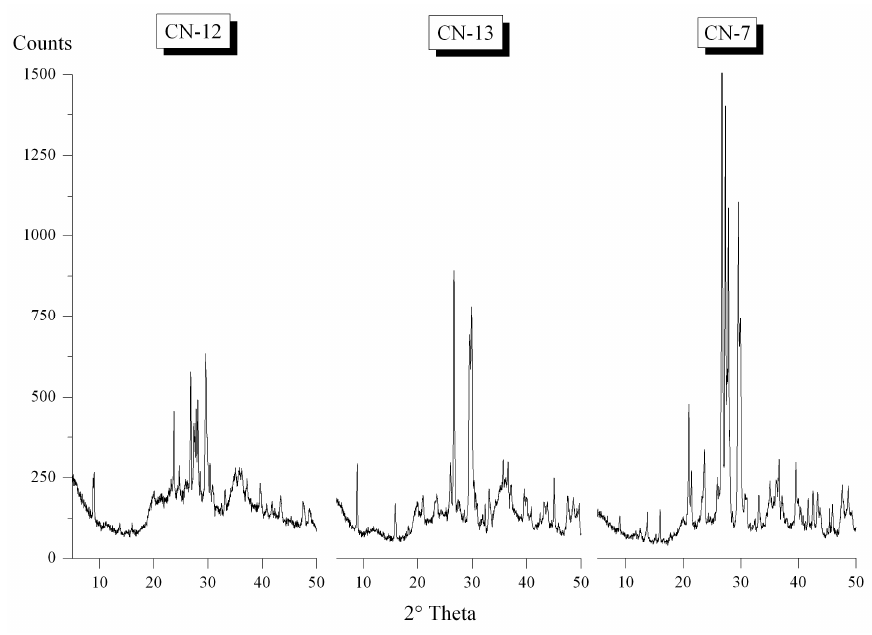
Figure 5. XRPD patterns of the three representative samples of mortars.